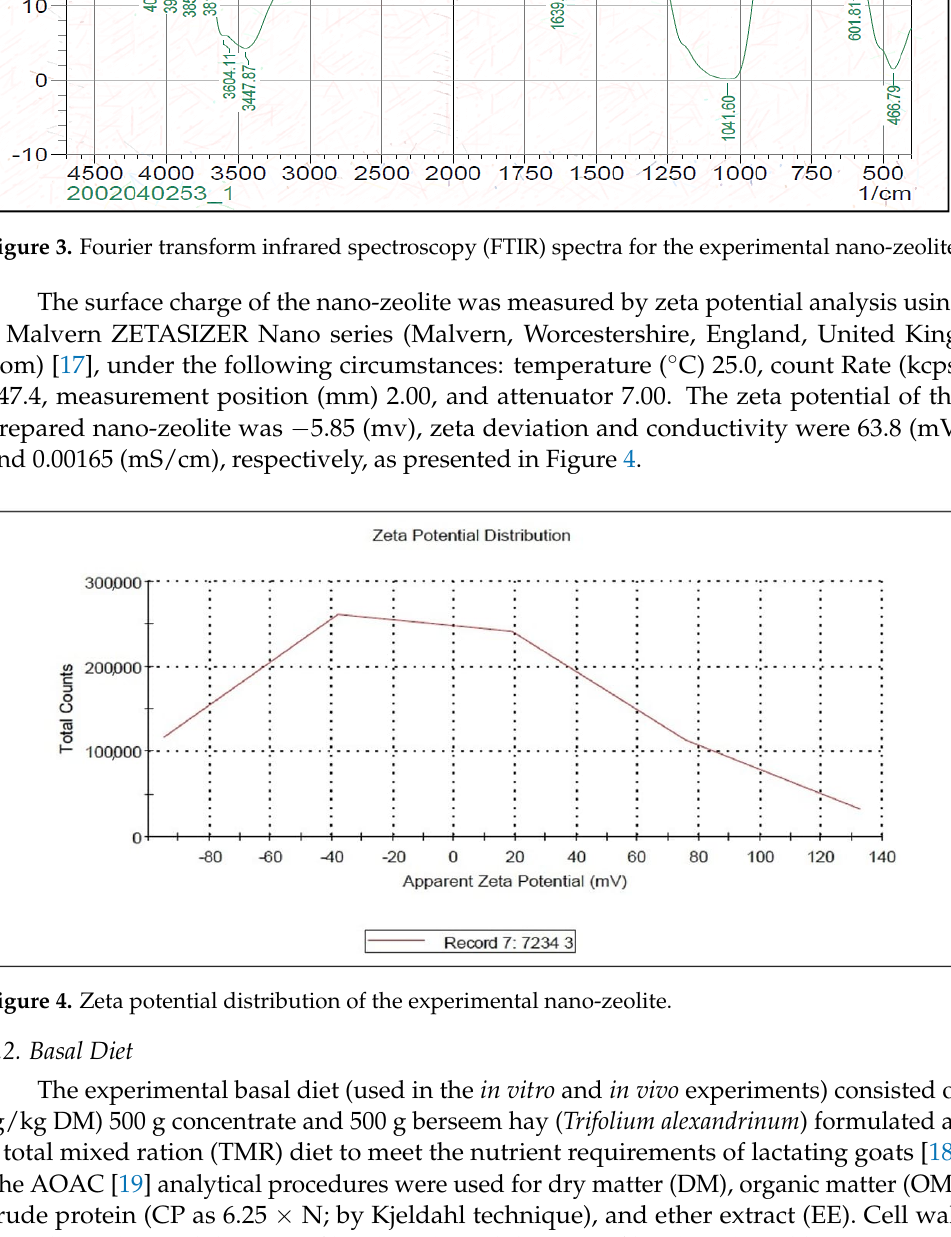
Table 2. Ingredients and chemical composition of experimental basal diet used in the in vitro and in vivo experiments.